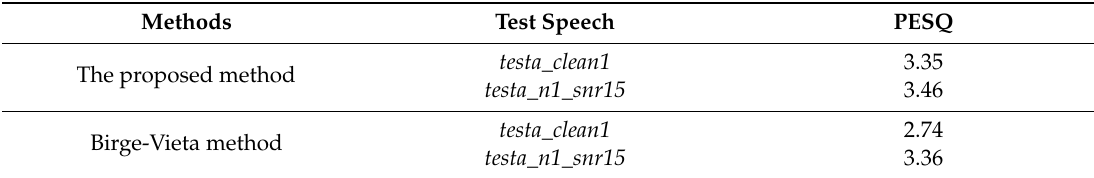
Table 8. PESQ comparison of the proposed method and the previous